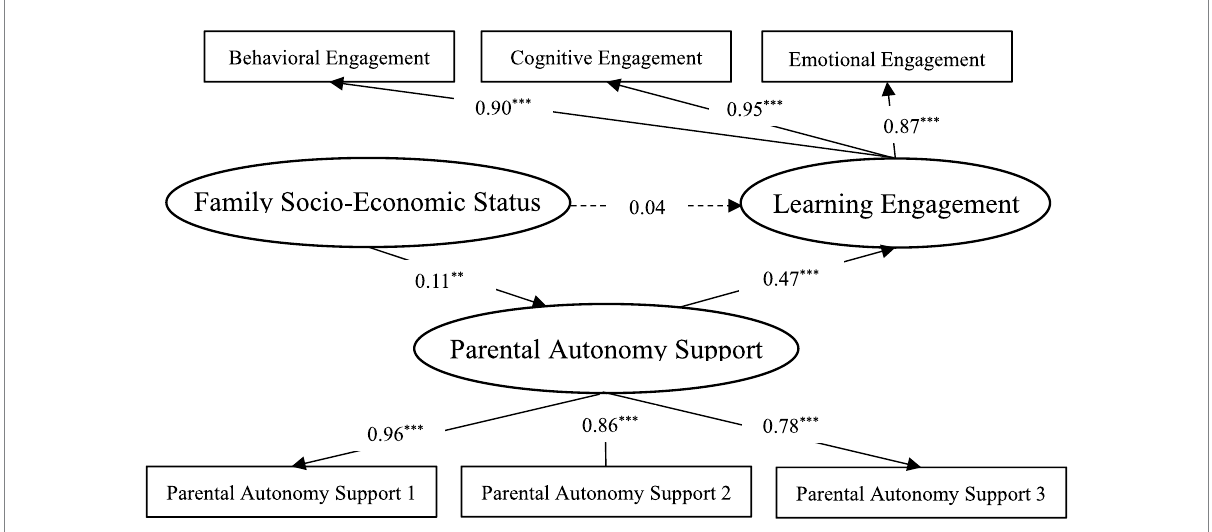
FIGURE 2 Standardized model diagram of the mediating role of parental autonomy support between family SES and learning engagement. * p < 0.05, ** p < 0.01, *** p <